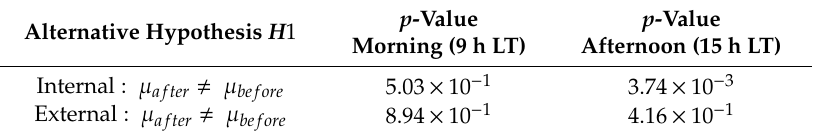
Table 5. p -values for K–S two-sided hypothesis test comparing the empirical frequency distribution of cloud reflectance (R) raw data in the internal and surroundings (external) areas of the reservoir. Null hypothesis H 0 : µ after = µ before